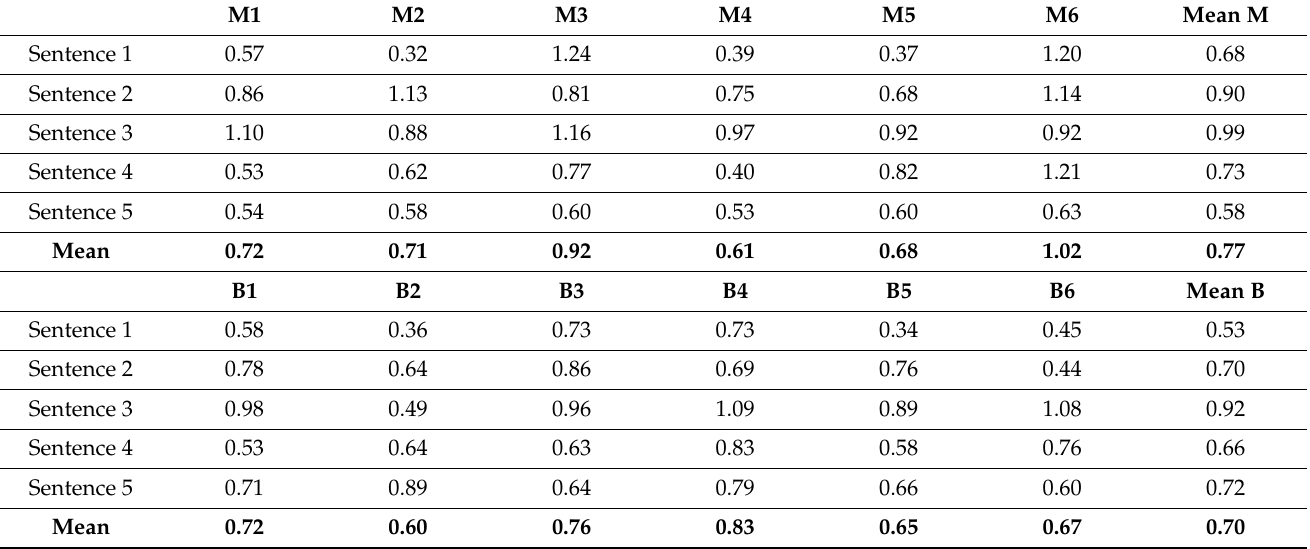
Table 6. Deviation from L1-F based on normalized F0 values (upper panel: group M; lower panel: group B).